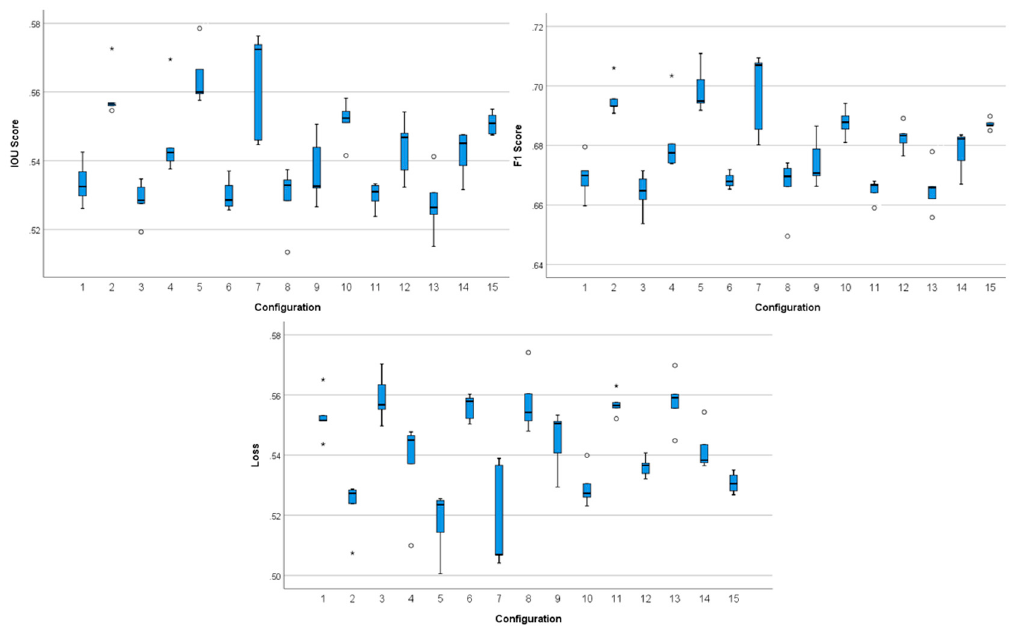
Figure 3. Boxplots of performance metrics obtained by the proposed hybrid configurations.